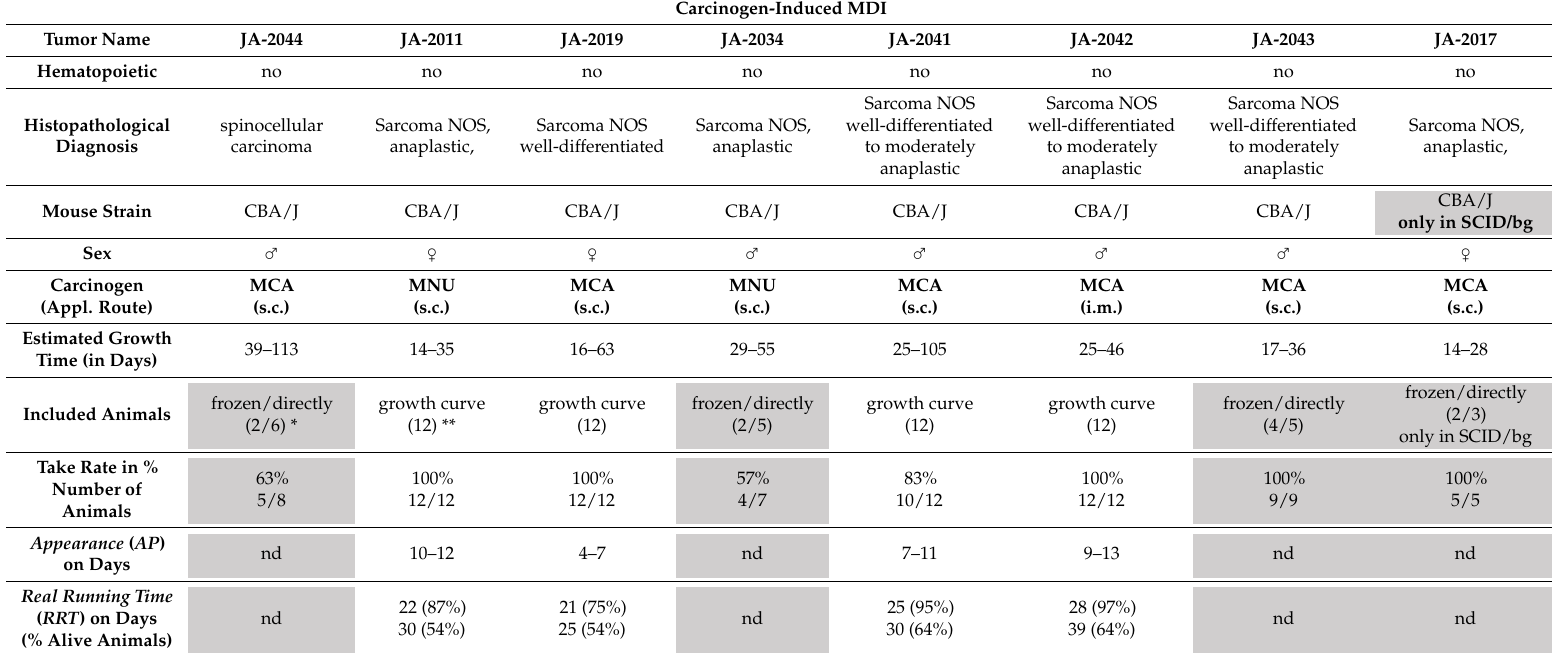
Table 2. Summary of established cMDI